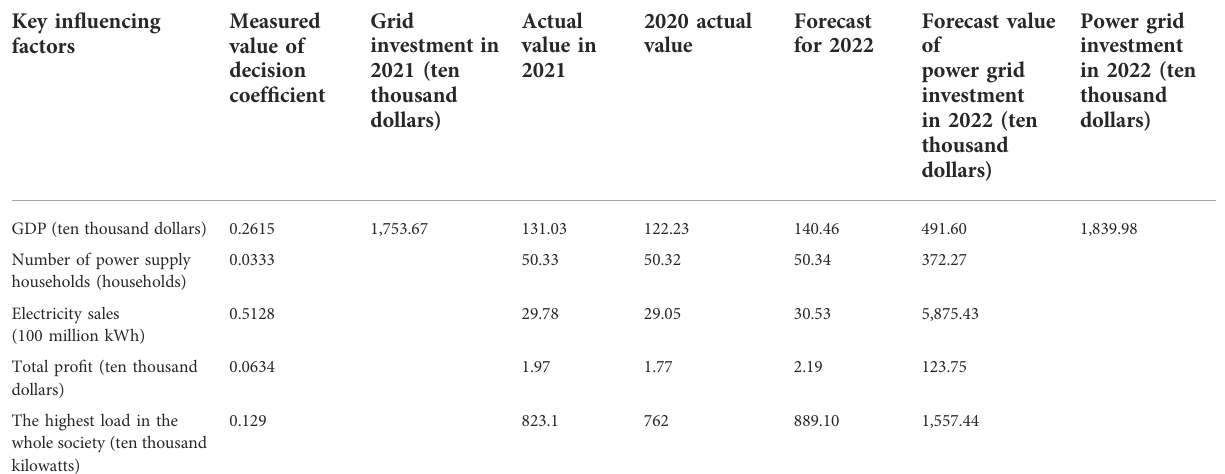
TABLE 4 Calculated results of power grid investment demand